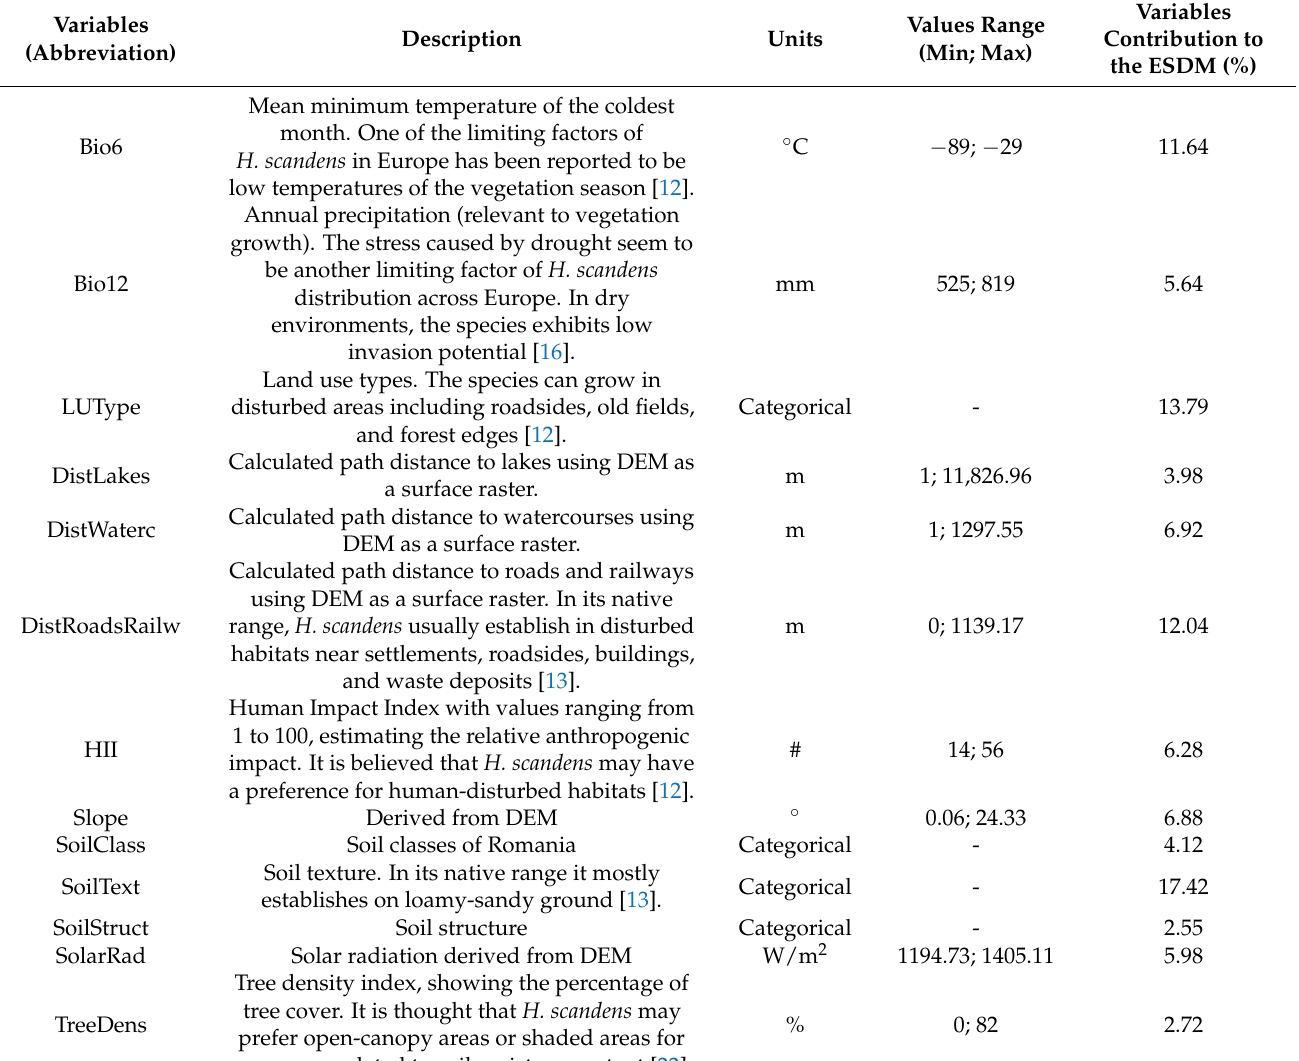
Table 2. Environmental variables used in the ensemble SDM and their contribution to the